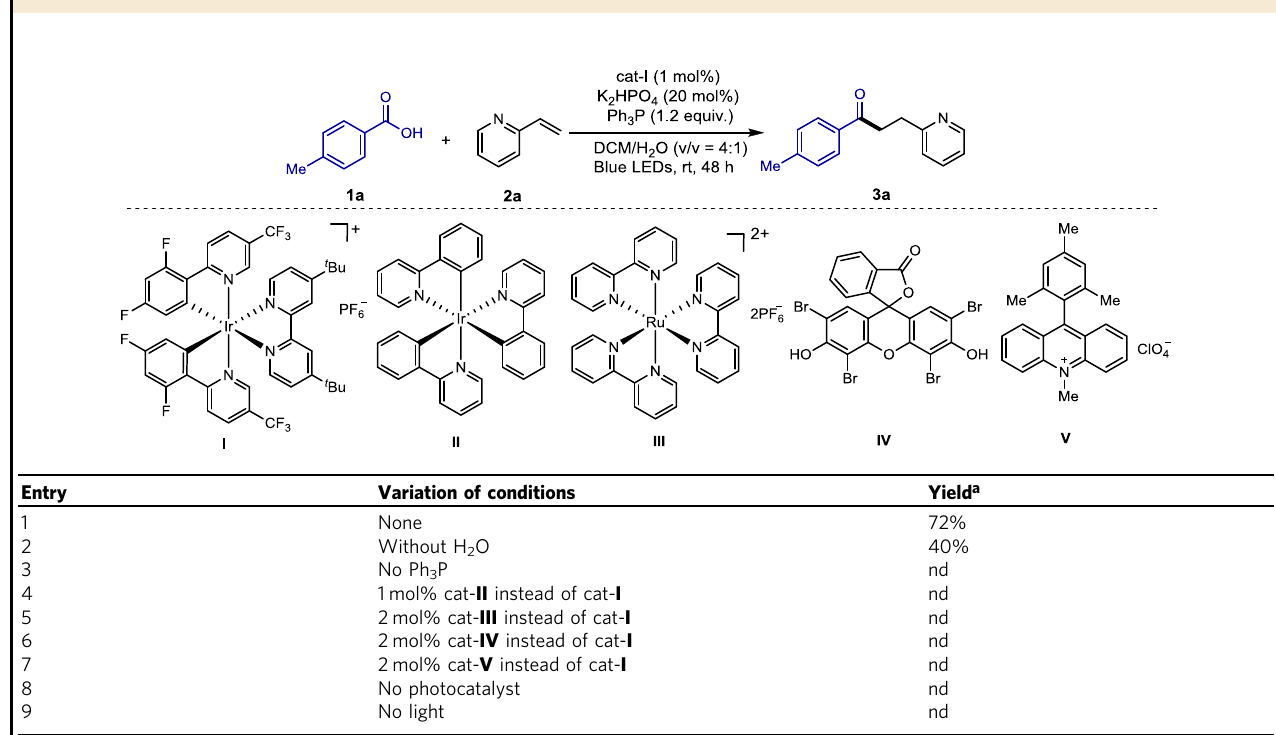
Table 1 Optimization of reaction